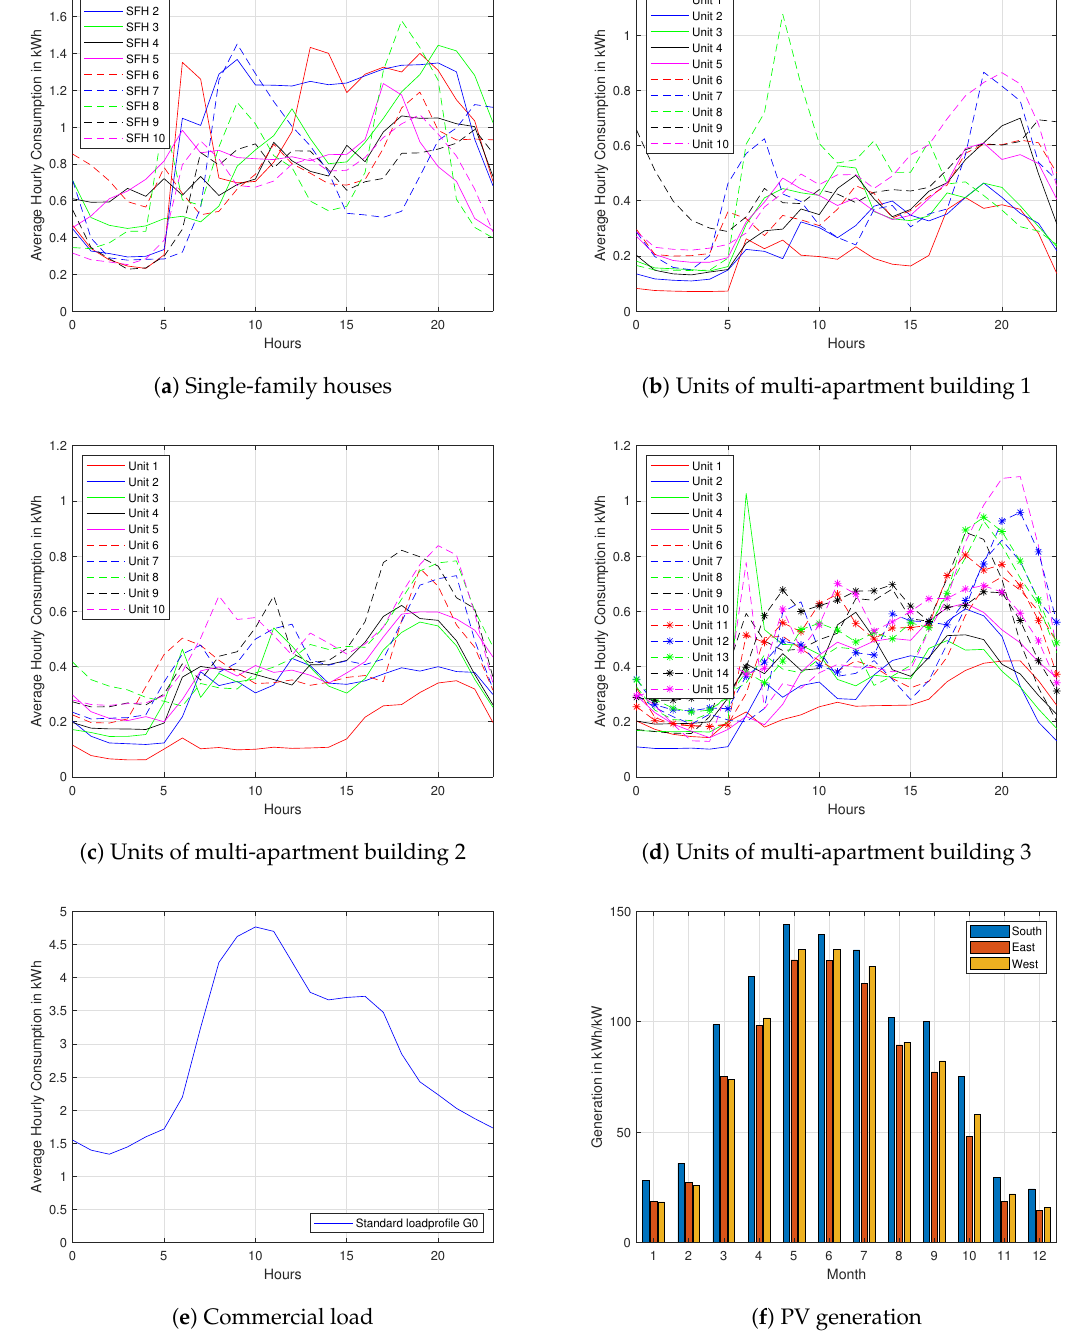
Figure 3. Overview of load and generation profiles: ( a – d ) show the demand of 10 considered single-family houses and 3 multi-apartment buildings. ( e ) shows the demand of the considered commercial customer. The loads are illustrated as the average hourly consumption for the period of one year. ( f ) shows the monthly PV generation in kWh/kW for different